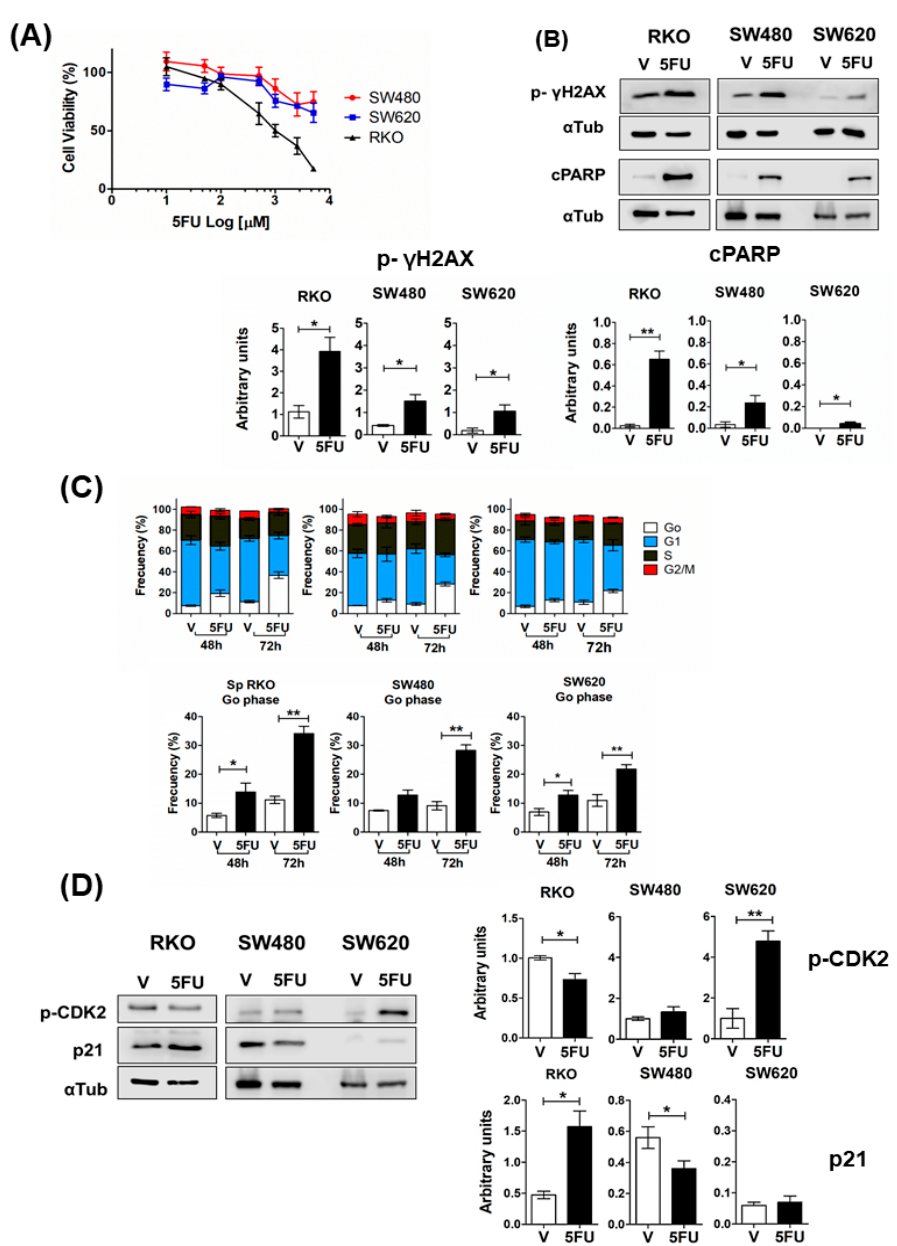
Figure 2. 5FU induces cell death and cell cycle arrest in CRC spheroids. ( A , B ) 5FU cytotoxicity on spheroids from colon cancer cell lines (RKO, SW480, and SW620). ( A ) Dose–response assay of spheroids treated with 5FU for 72 h. Cell viability was determined using the CellTiter-Glo 3D Kit. ( B ) Upper panel: Representative immunoblots of cleaved PARP (cPARP) and phospho-histone γ H2AX (Ser 139) in spheroids after 72 h of treatment with 5FU or vehicle (V). α -tubulin was used as a loading control. Lower panel: quantification of the relative expression levels of the indicated proteins in the upper panel. ( C ) Upper panel: cell cycle distribution determined by Ki67 detection and propidium iodide staining in spheroids treated with 5FU for 48 and 72 h. Lower panel: a comparative analysis of the Go phase between spheroids treated with or without 5FU at the indicated time points. ( D ) Left panel: representative immunoblots of phospho-CDK2 (Thr160) and p21 in spheroids after 72 h of treatment with 5FU or vehicle (V). α -tubulin ( α Tub) was used as a loading control. Right panel: quantification of the relative expression levels of the indicated proteins in the left panel. Data are represented as the mean values ± SEM of at least three independent experiments. Student’s t -test * p < 0.05; ** p <